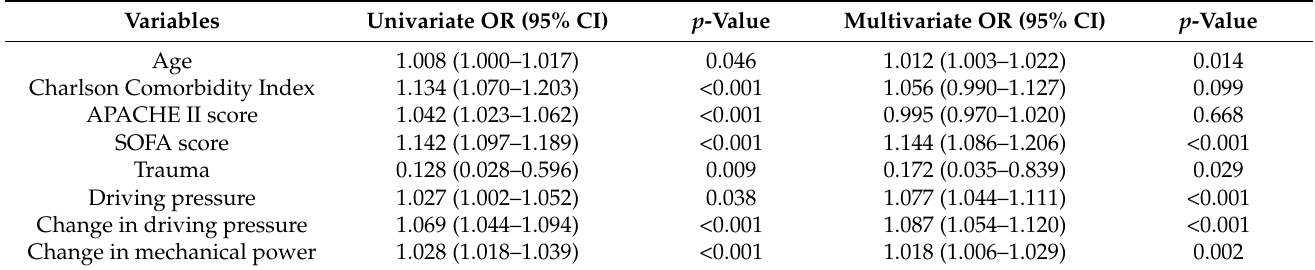
Table 2. Binary logistic regression to analyze the independent factors associated with 30-day